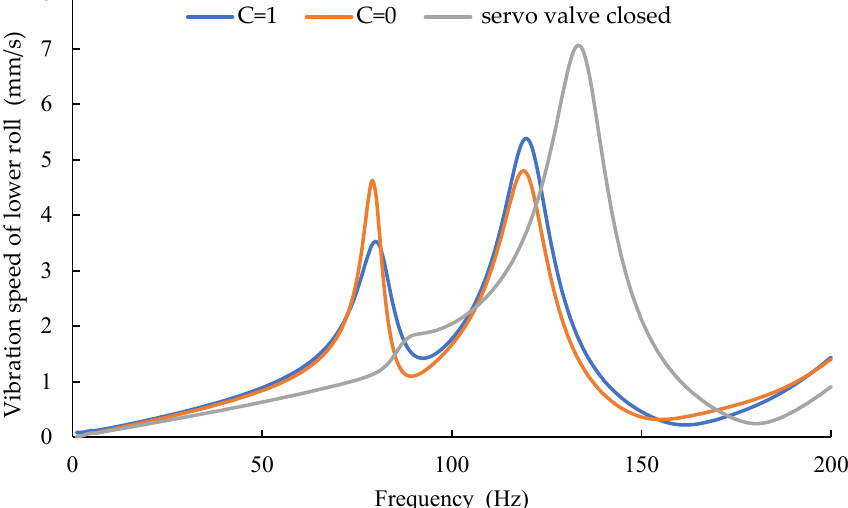
Figure 10. Amplitude frequency diagram of lower work roll vibration speed.